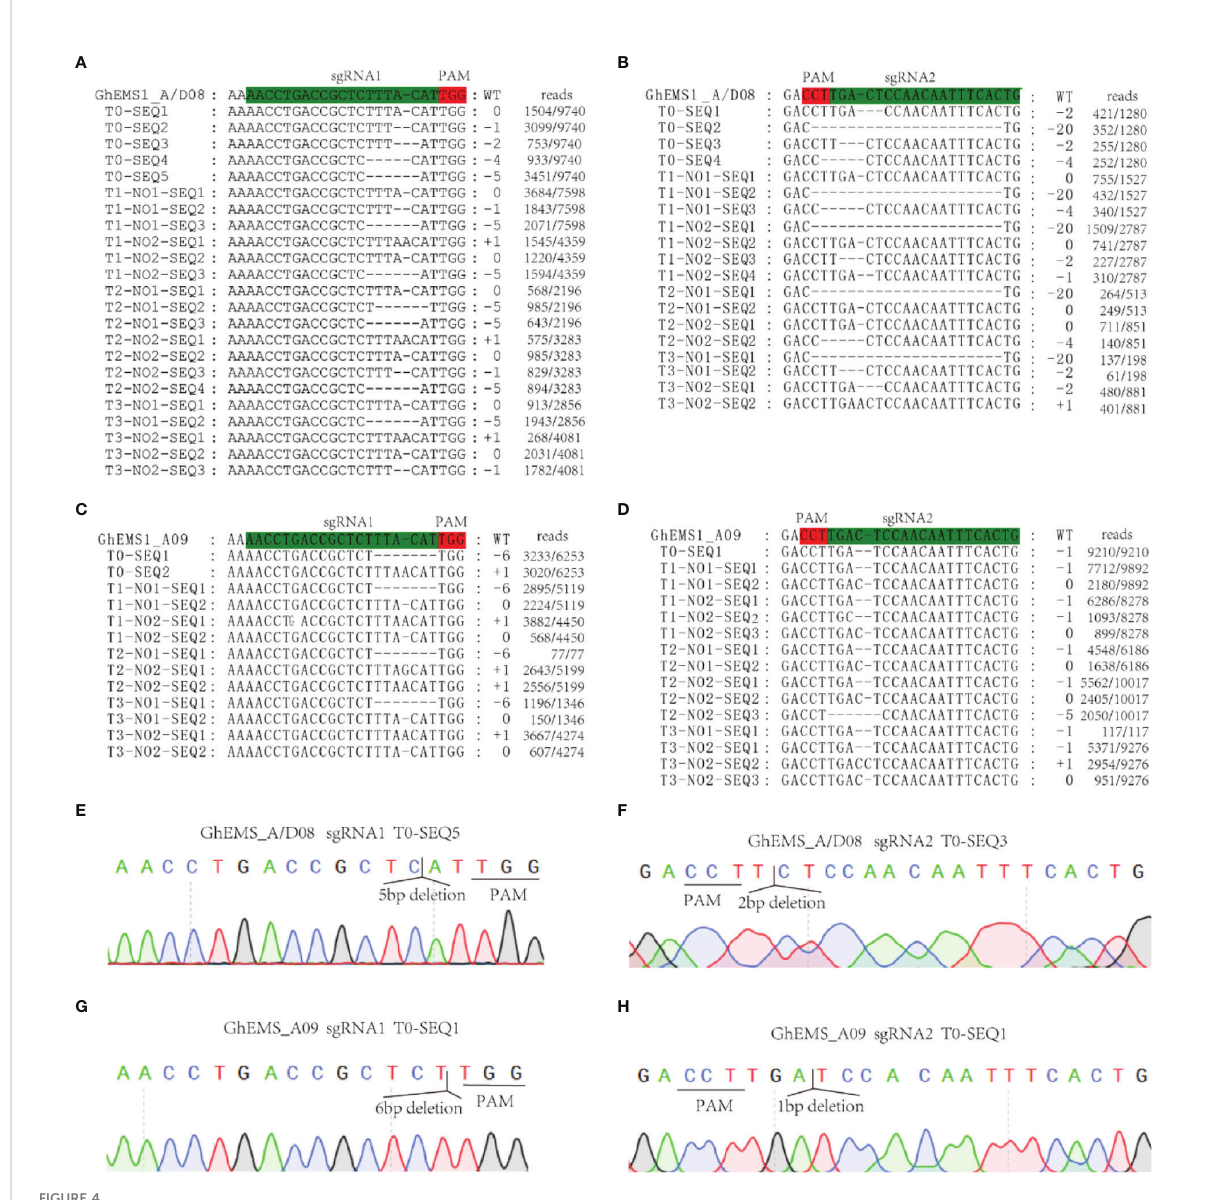
FIGURE 4 KO1 editing types were inherited in T0 to T3. (A, B) GhEMS_A/D08 were edited in sgRNA1 and sgRNA2, respectively. (C, D) GhEMS_A09 were edited in sgRNA1 and sgRNA2, respectively. (E) Sequencing peak photos of GhEMS_A/D08 with 5 bp deletions at the sgRNA1 site. (F) Sequencing peak photos of GhEMS_A/D08 with 2 bp deletions at the sgRNA2 site. (G) Sequencing peak photos of GhEMS_A09 with 6 bp deletions at the sgRNA1 site. (H) Sequencing peak photos of GhEMS_A09 with 1 bp deletions at the sgRNA2